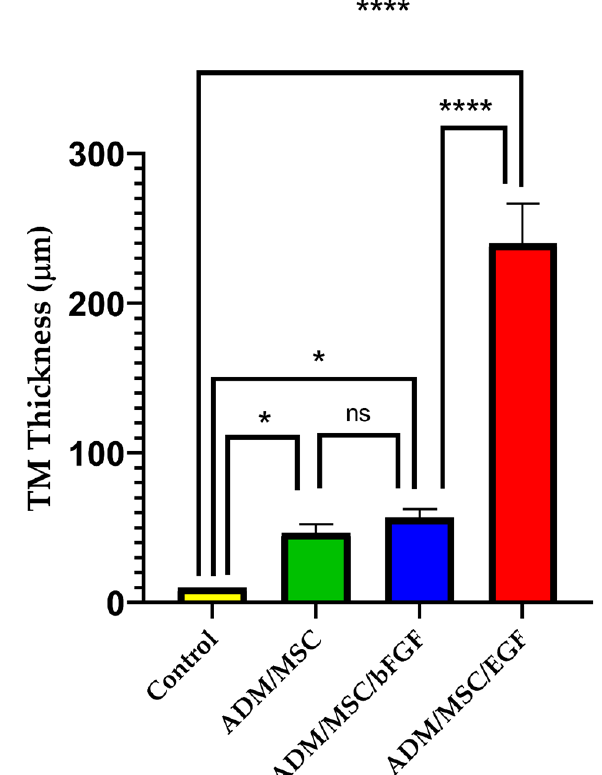
Figure 5. ( A ) HE stain showed the neodrum in each group. Compared to the control group, other groups showed greater thickening of neodrum in TM regeneration. Among them, ADM/MSC/EGF group revealed the most thickened neodrum. Staining for Ki-67, a proliferation marker, shows keratinocyte formation in the epithelial layer. The ADM/MSC/EGF group showed keratinocyte formation in the epithelial layer (arrows). ( B ) The mean thickness of the neodrum in each group was analyzed by ANOVA test with Tukey post hoc multicomparison test. * p < 0.05, **** p < 0.0001, ns = not significant expla- nation.